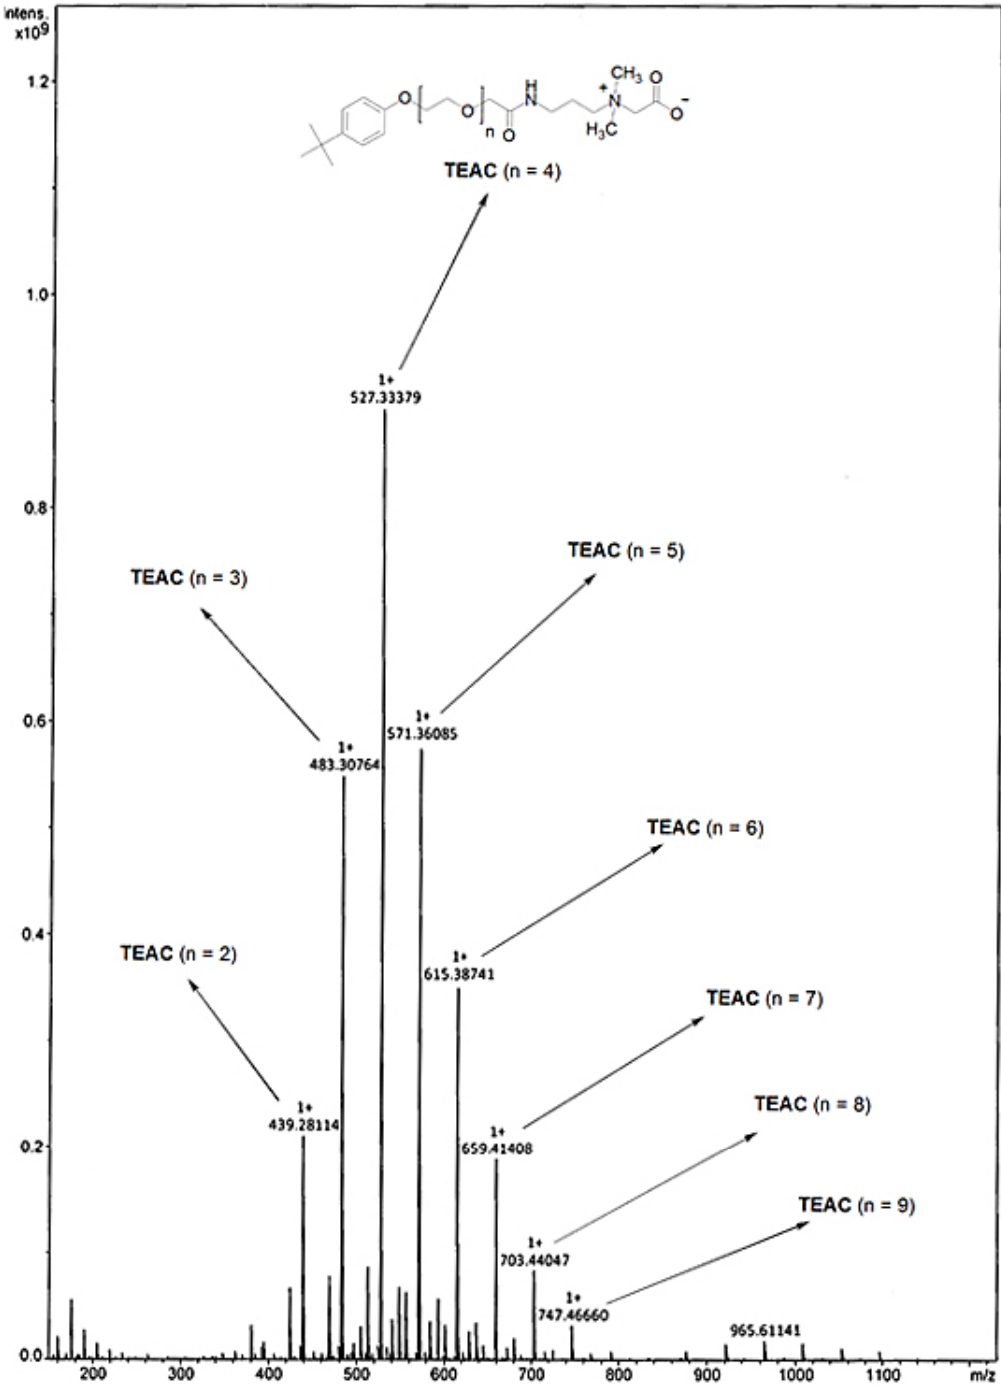
Figure 5. Matrix-assisted laser desorption/ionization time-of-flight (MALDI-ToF) mass spectra of TEAC . Table 4. MALDI-ToF-MS analysis of zwitterionic surfactants (TEAC, TEAS, TEAH, NEAS, NEAC, and NEAH).